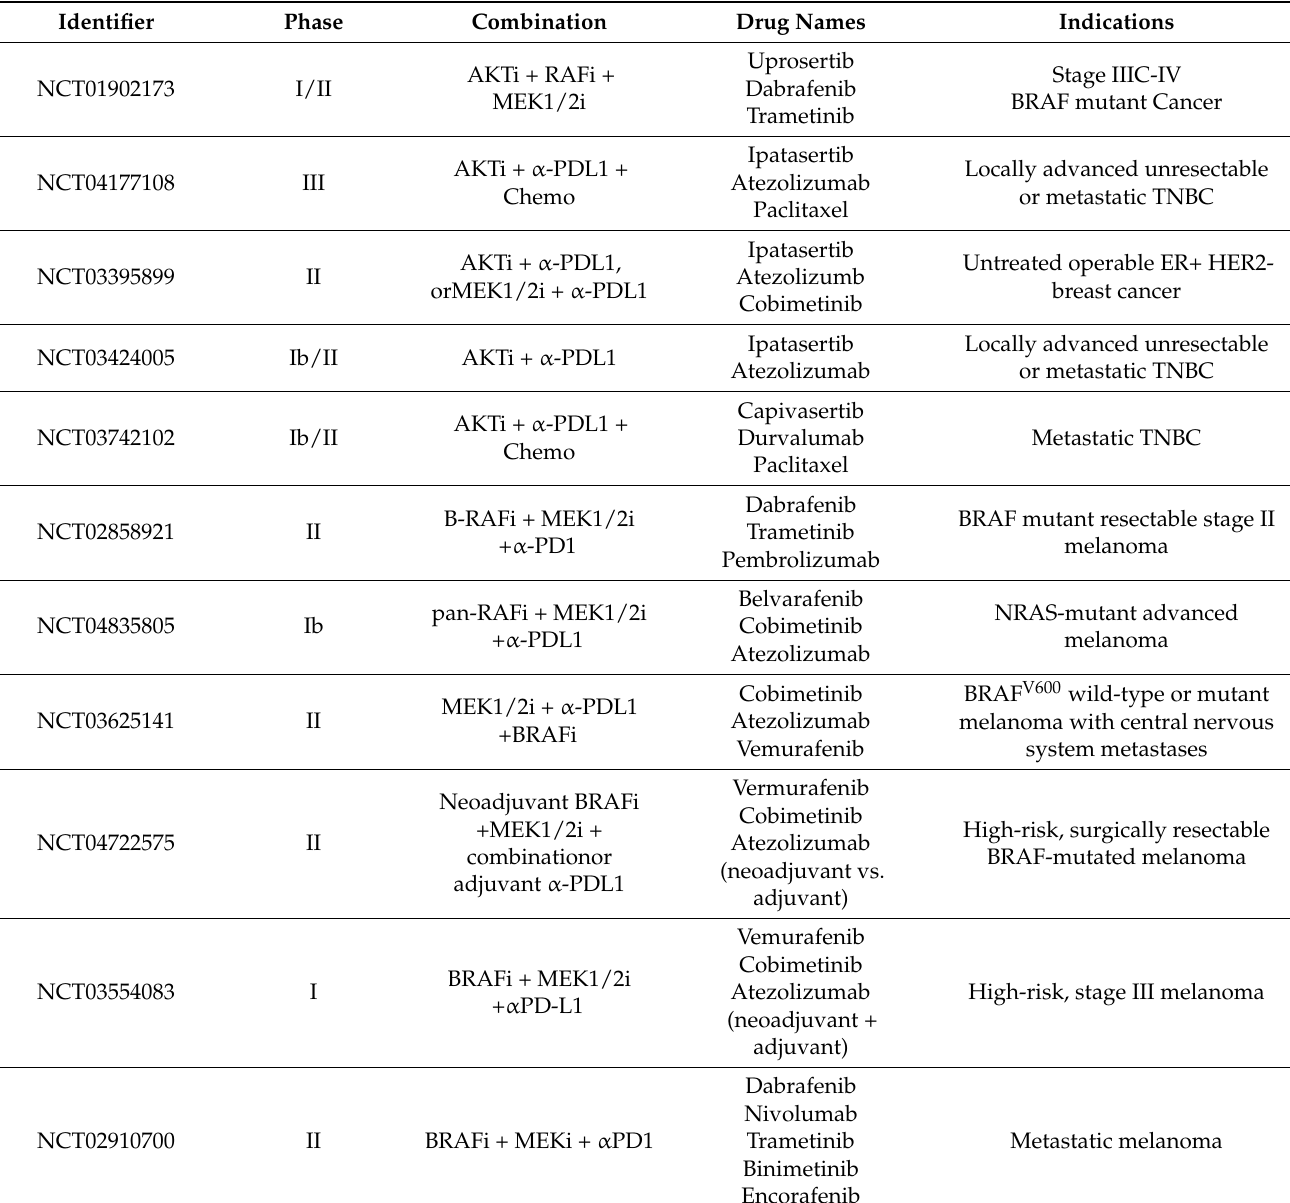
Table 1. Ongoing clinical trials combining immune checkpoint inhibitors with inhibitors of the PI3K/AKT/mTOR pathway or MAPK pathway in melanoma and